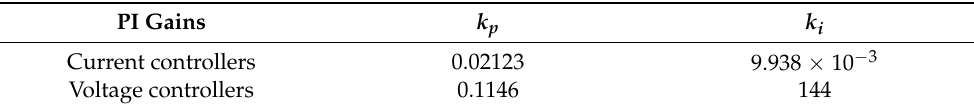
Table A5. Parameters of PI controllers.